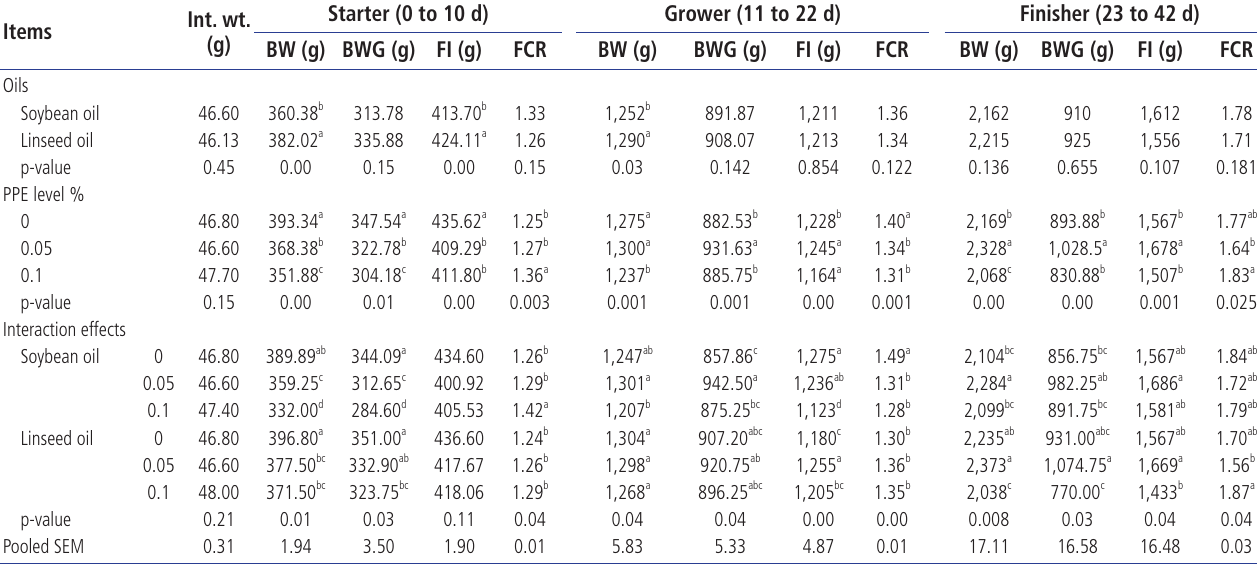
Table 4. Effects of different dietary levels of pomegranate peel extract with different oil sources and their interactions on body weight, body weight gain, feed intake, and feed conversion ratio during the experimental periods Items Oils Soybean oil Linseed oil